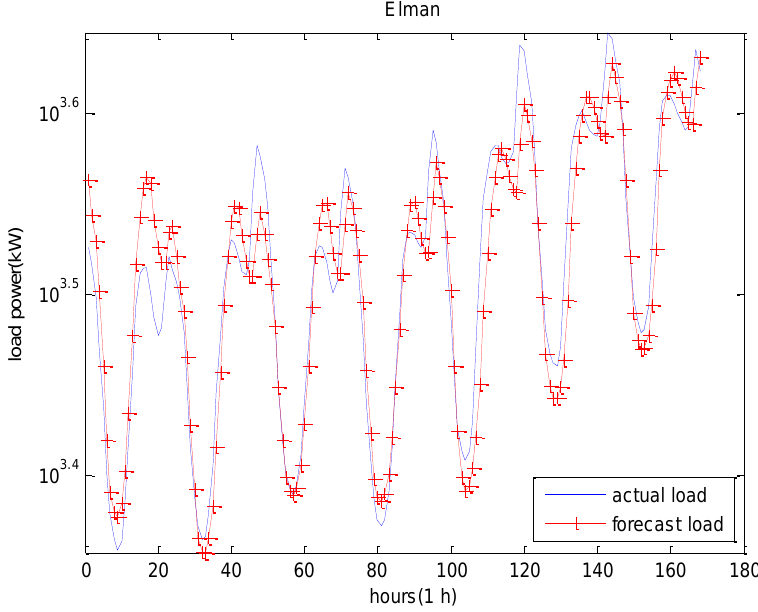
Figure 11. The forecast results of seven consecutive days using Elman model.